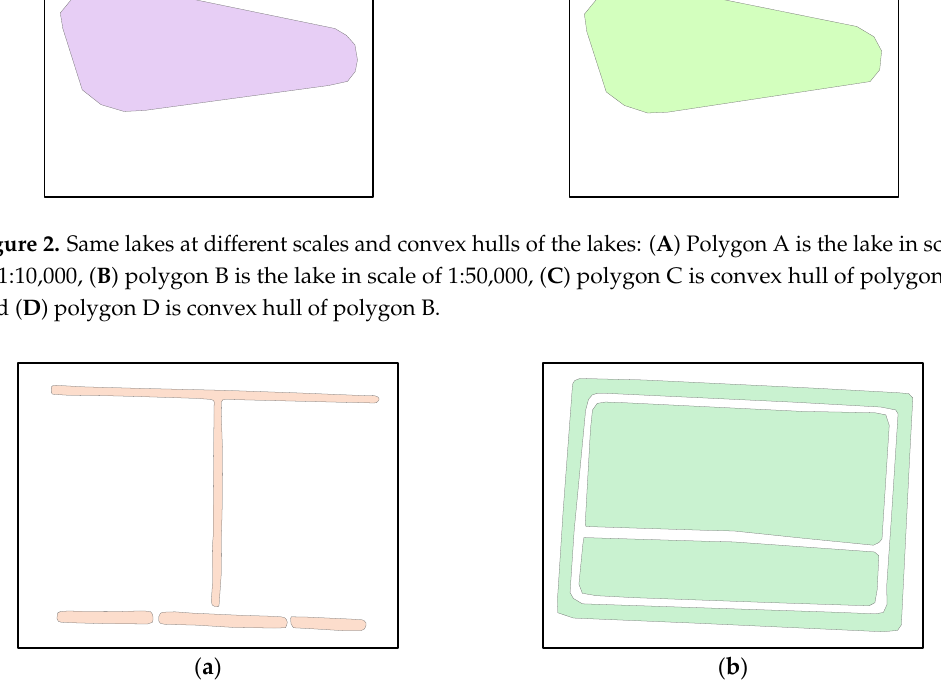
Figure 3. Different areal entities with similar convex hulls: ( a ) the canals and ( b ) the canal with two pools.